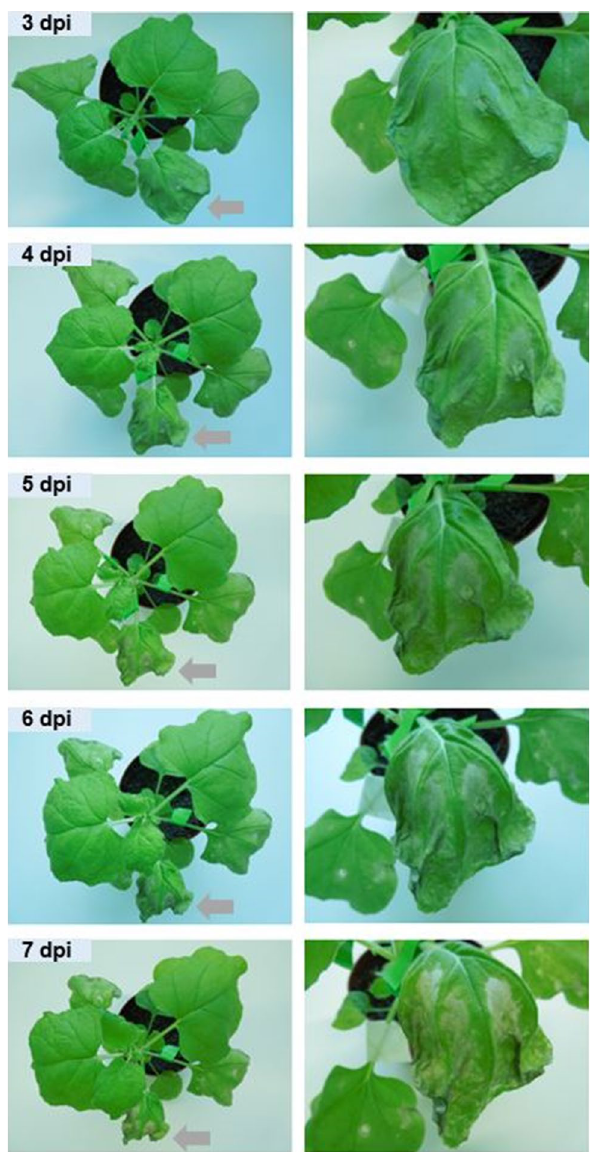
left side pictures are shown with magnification in the right side